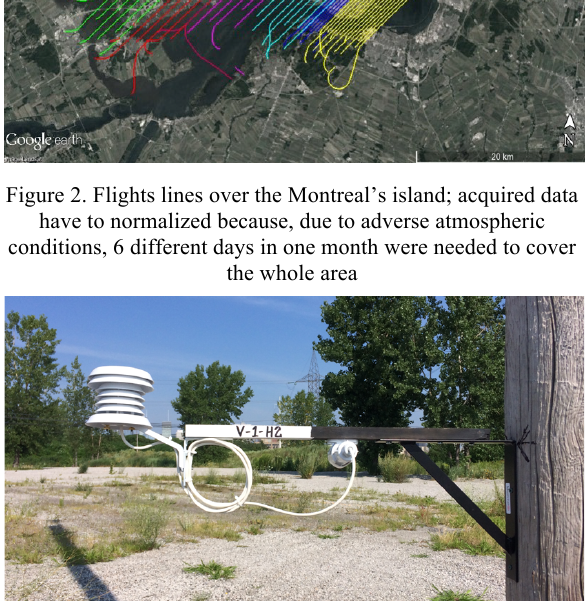
Figure 3. Combination of sensors for synchronous measurements of surface temperature (iButton) and air temperature (Hobo) to establish their relationship for various surface cover materials